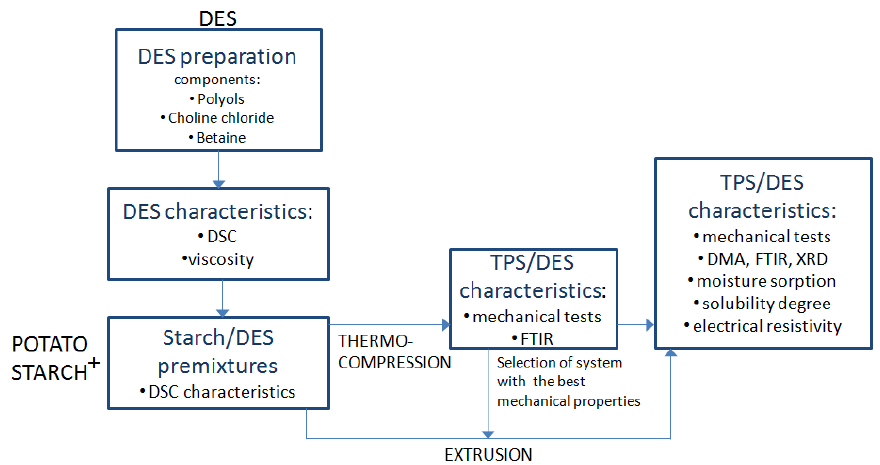
Scheme 1. Flow chart of experimental design presented in this